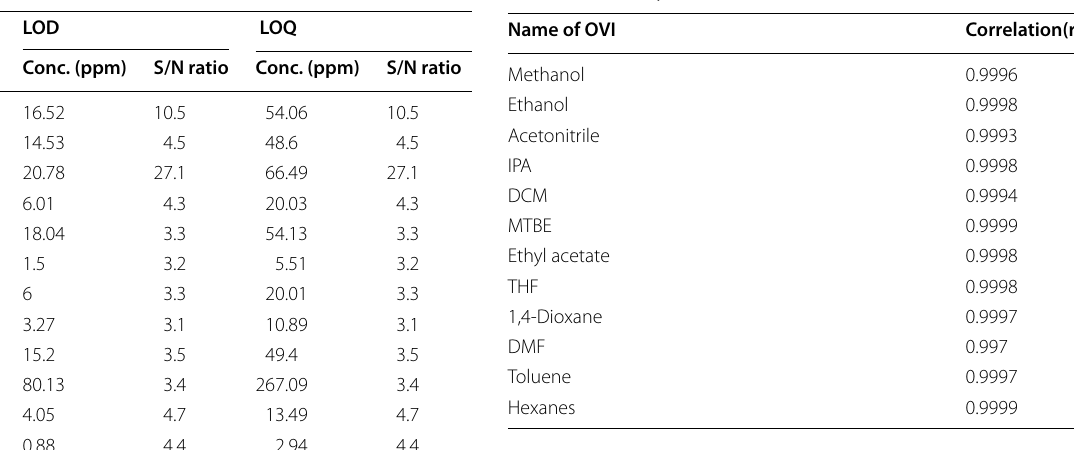
Table 4 LOD and LOQ